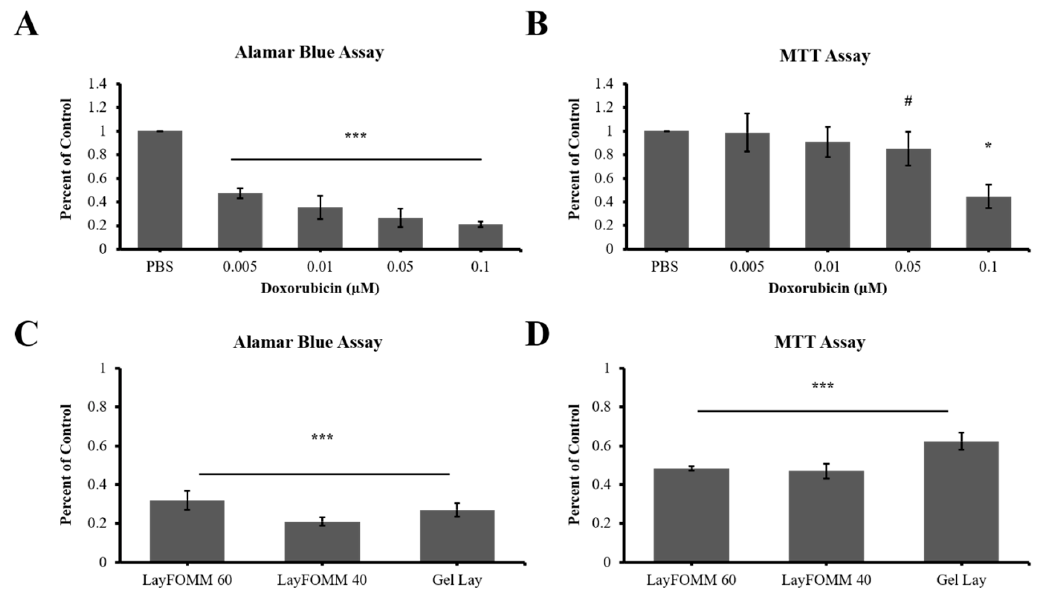
Figure 6. Patient derived spine metastases cells (secondary to prostate cancer) following direct and DOX-loaded scaffold treatment. ( A ) Direct treatment of patient derived cells with DOX showing significantly decreased metabolic activity with all the ranges tested over 7 days using Alamar assay. ( B ) MTT metabolic activity assessment of patient derived cells decreased with only the highest concentration of DOX. ( C ) 3D printed scaffold DOX release leading to decreased Alamar assessment of metabolic activity of patient derived cells over 7 days. ( D ) MTT assessment of metabolic activity of patient derived cells after treatment with 3D printed scaffold loaded with Dox for 7 days. Experiments were performed over a single trial in triplicate form cells isolated from a single donor. Error bars represent ± SD between each experiment (* = p < 0.05, *** = p < 0.001, # denotes p = 0.07).